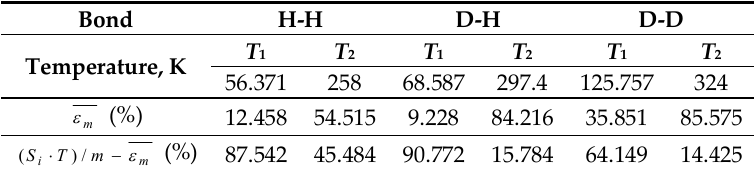
Table 3. Comparison of the average energy of the elementary activation act and its uncertainty for sequential deuteration of the hydrogen bond.